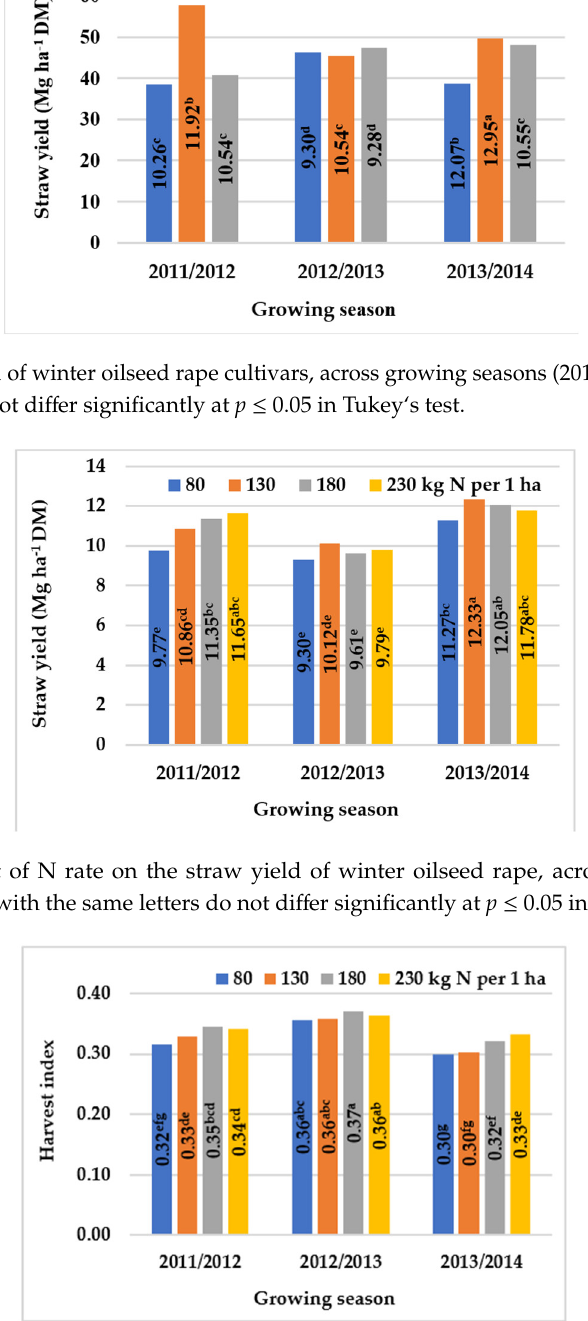
Figure 8. The effect of N rate on the harvest index of winter oilseed rape, across growing seasons (2011–2014). Means with the same letters do not differ significantly at p ≤ 0.05 in Tukey`s test.